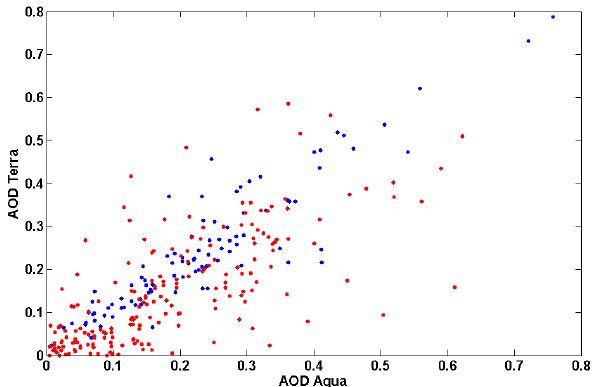
Fig. 5: Intercomparison of the mean MODIS-derived AOD along the CALIPSO tracks (96 blue dots) and near Ispra site (233 red dots) when considering Terra and Aqua platforms.